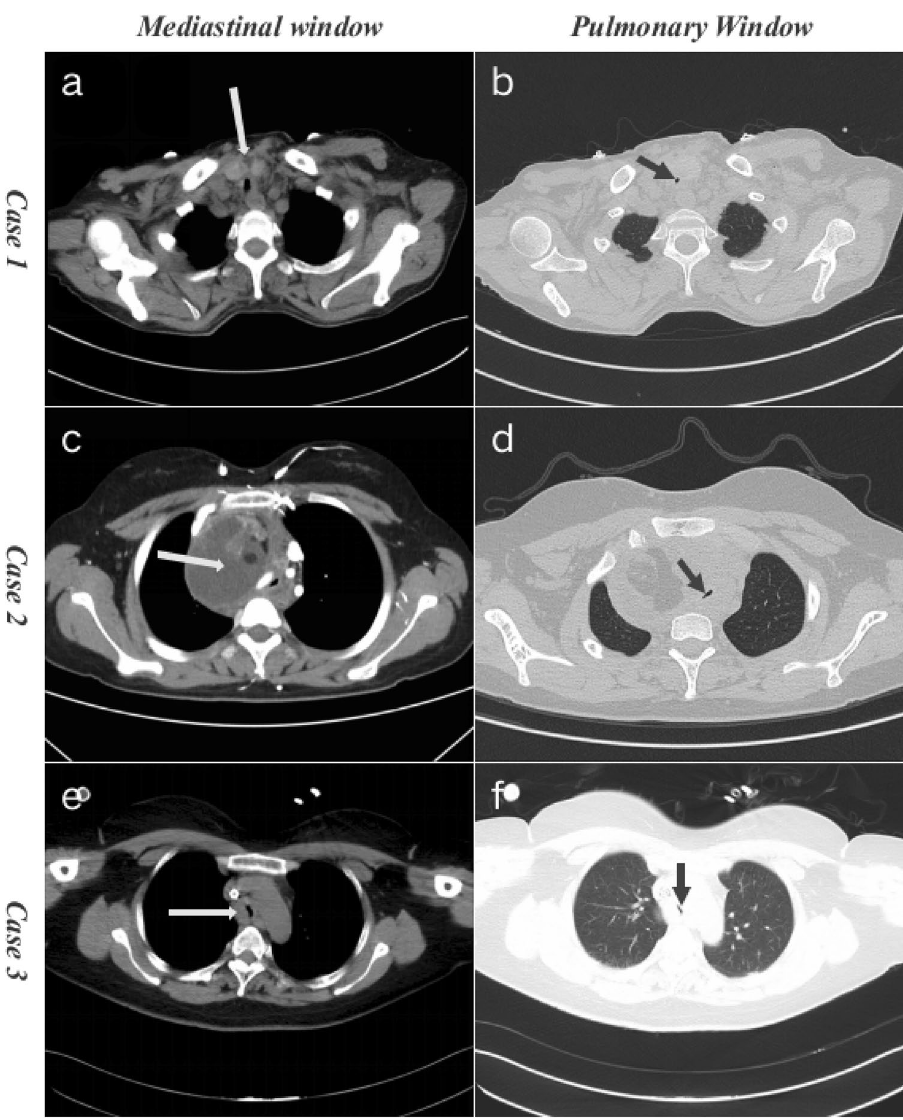
Figure 2. CT scans of severe central airway obstruction patients caused by neck and chest tumors before ECMO (Axial view). White arrow shows tumors. Black arrow shows severe central airway obstruction. Thickening of thyroid isthmus, multiple enlarged neck lymph nodes and critical airway stenosis of Case 1 ( a , b ). Mediastinal huge mass and critical airway stenosis of Case 2 ( c , d ). Thickening of carina and critical airway stenosis of Case 3 ( e–f